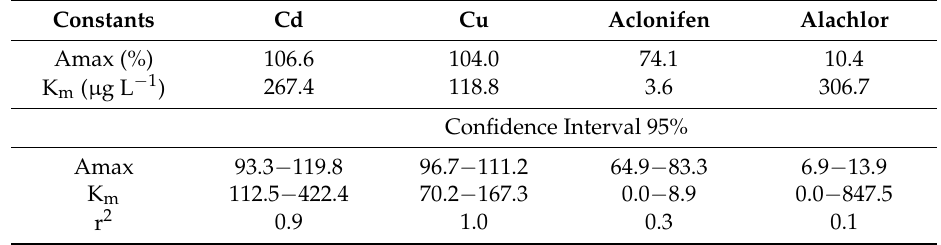
Figure 4. Adsorption percentage of Cd ( a ), Cu ( b ), Aclonifen ( c ) and Alachlor ( d ) as a function of the suspended particulate matter load. 1 and 2 are duplicates. Pollutant spikes are 10 µ g L − 1 . Table 4. Am and Km constants determined by the fitting of the experimental values for Cd, Cu, Aclonifen and Alachlor following the Michaelis-Menten